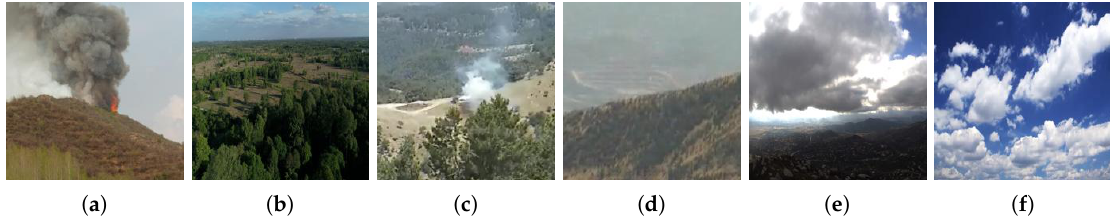
Figure 1. Samples of our training dataset. ( a , b ) are gathered from the Internet; ( c , d ) are from FIRESENSE Database; ( e , f ) are cloud images.